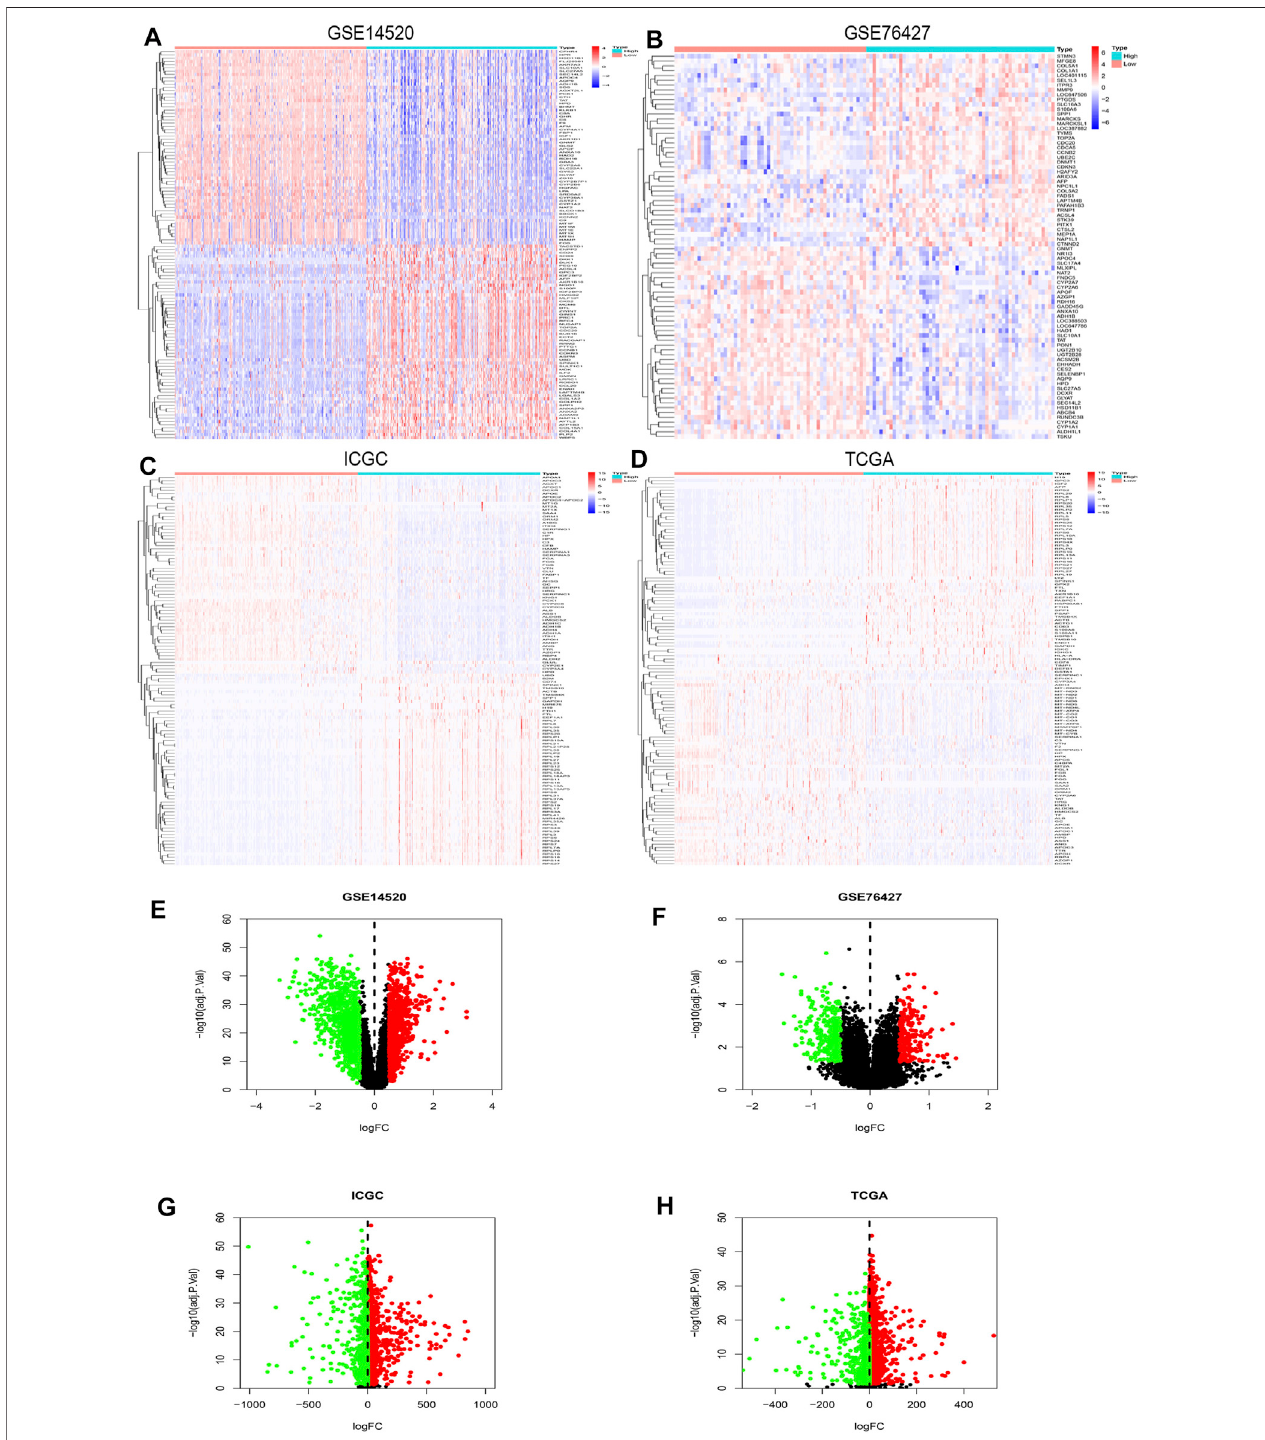
FIGURE2| DEGs ’ heatmapandvolcanoplotinGSE14520,GSE76427,ICGC, andTCGA: (A) TheheatmapinGSE14520, (B) theheatmapinGSE76427, (C) the heatmapin ICGC, (D) the heatmap inTCGA, (E) thevolcanoplotinGSE14520, (F) thevolcano plotinGSE76427, (G) thevolcanoplotin ICGC, and (H) thevolcanoplot inTCGA.Intheheatmaps,thehighexpression representedred,andblue represented thelowexpression. Redshowedtheupregulation genesinthevolcanoplots,and green presented the downregulation genes. In addition, the black dots were not the differential gene in expression in the volcano plots.